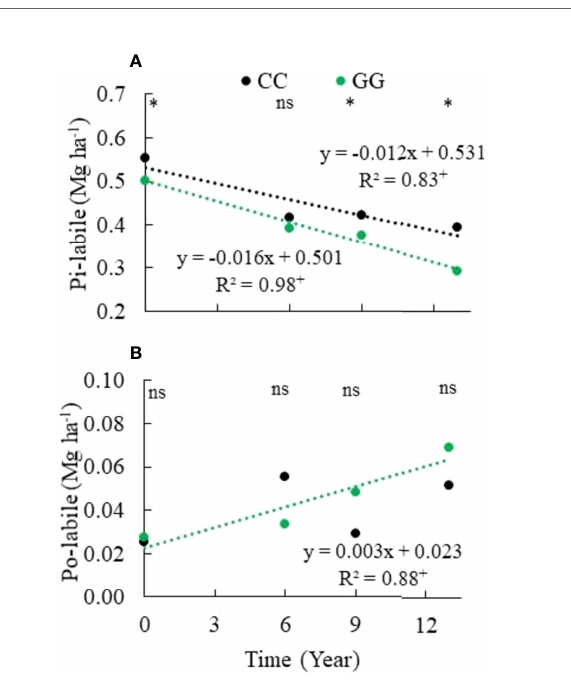
FIGURE 6 | Trends of (A) inorganic labile P and (B) organic labile P in the 0- 30 cm topsoil layer under different soil management systems. CC – permanent conventional crop rotations (corn, winter wheat, and barley crops) and GG- permanent grassland. ns Not signi fi cant. *Signi fi cant in the Scott – Knott test (p ≤ 0.05). + Signi fi cant at p ≤